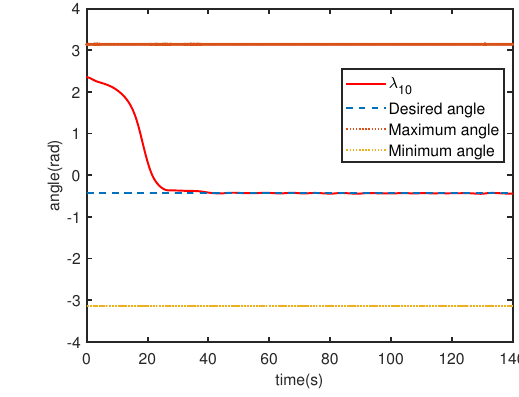
( b ) Angle between the leader and USV 1. Figure 4. Cont